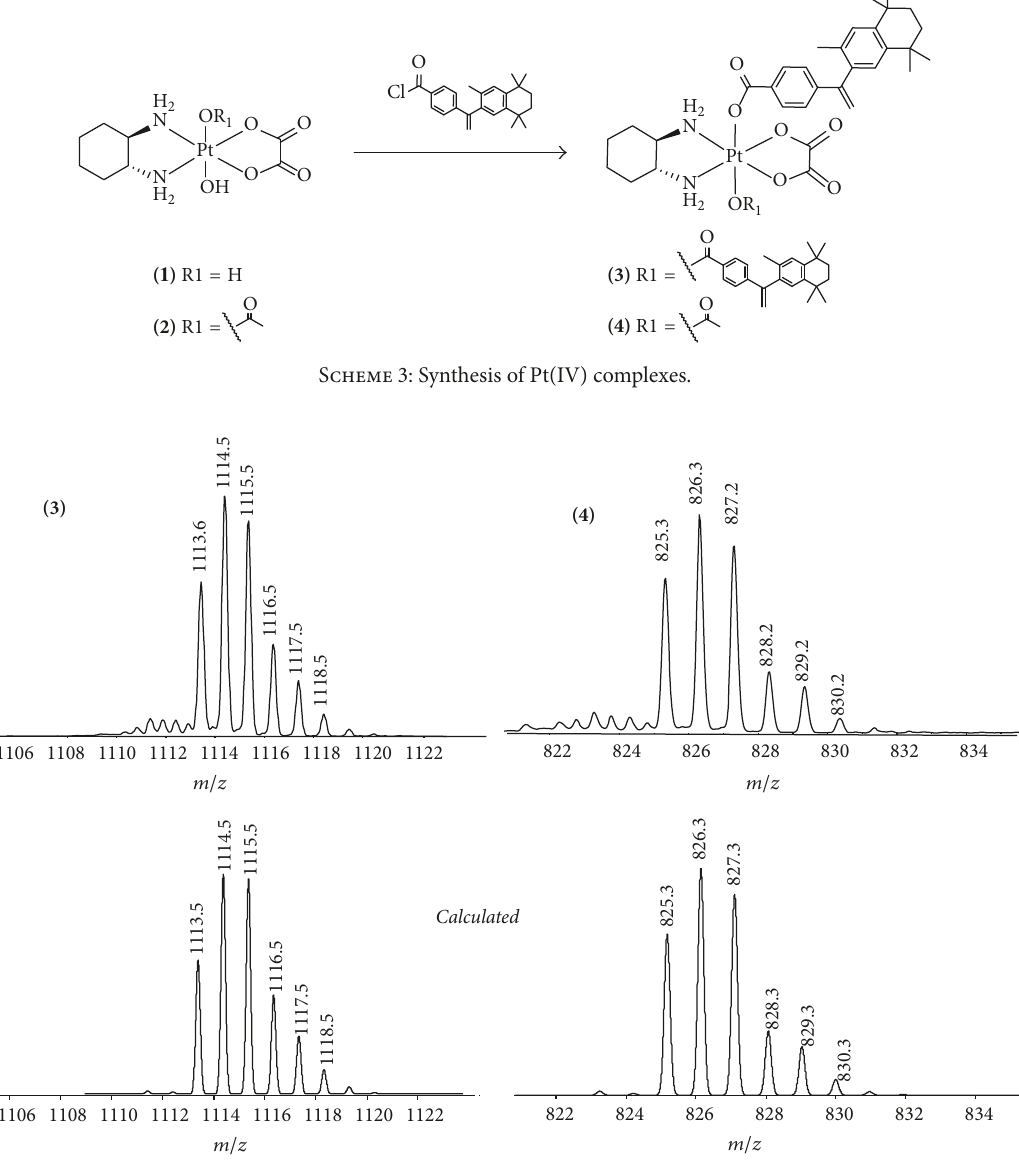
Figure 1: ESI-MS corresponding to [M+Na + ] + for complexes 3 and 4